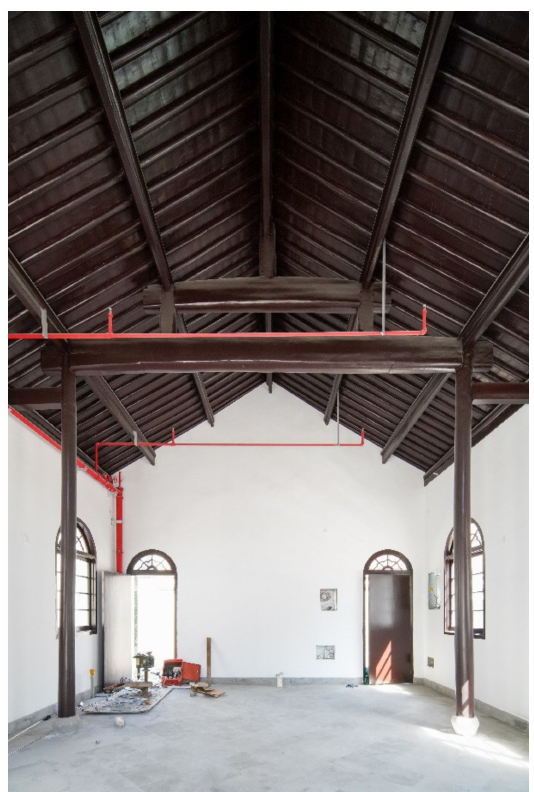
Figure 18. The traditional Chinese roof-truss system of the Xiaguan Catholic Church.